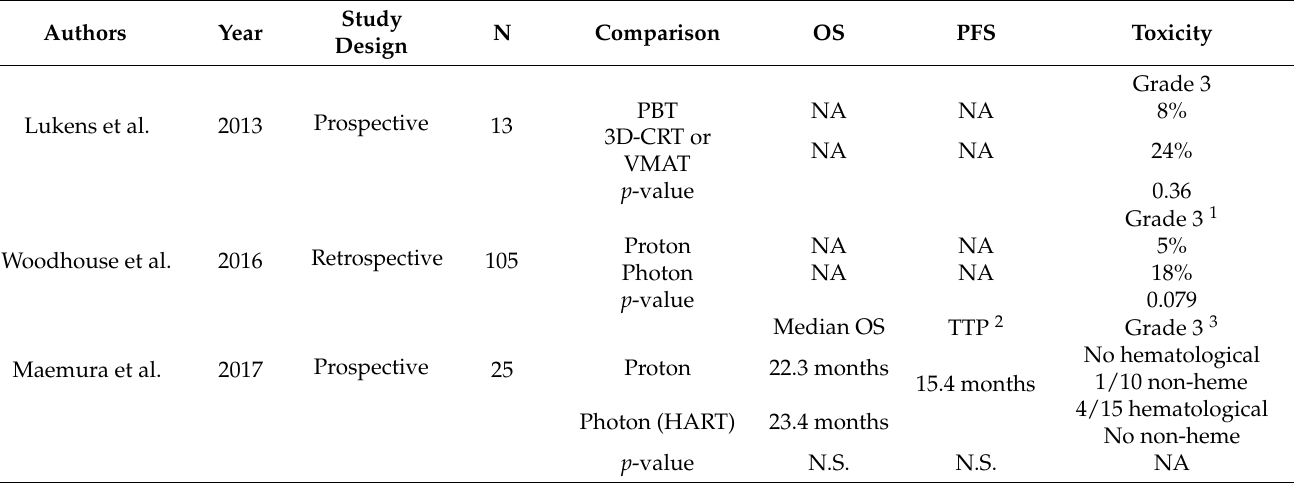
Table 1. Studies summarizing outcomes and toxicities associated with the use of proton versus photon radiation therapy for the treatment of pancreatic